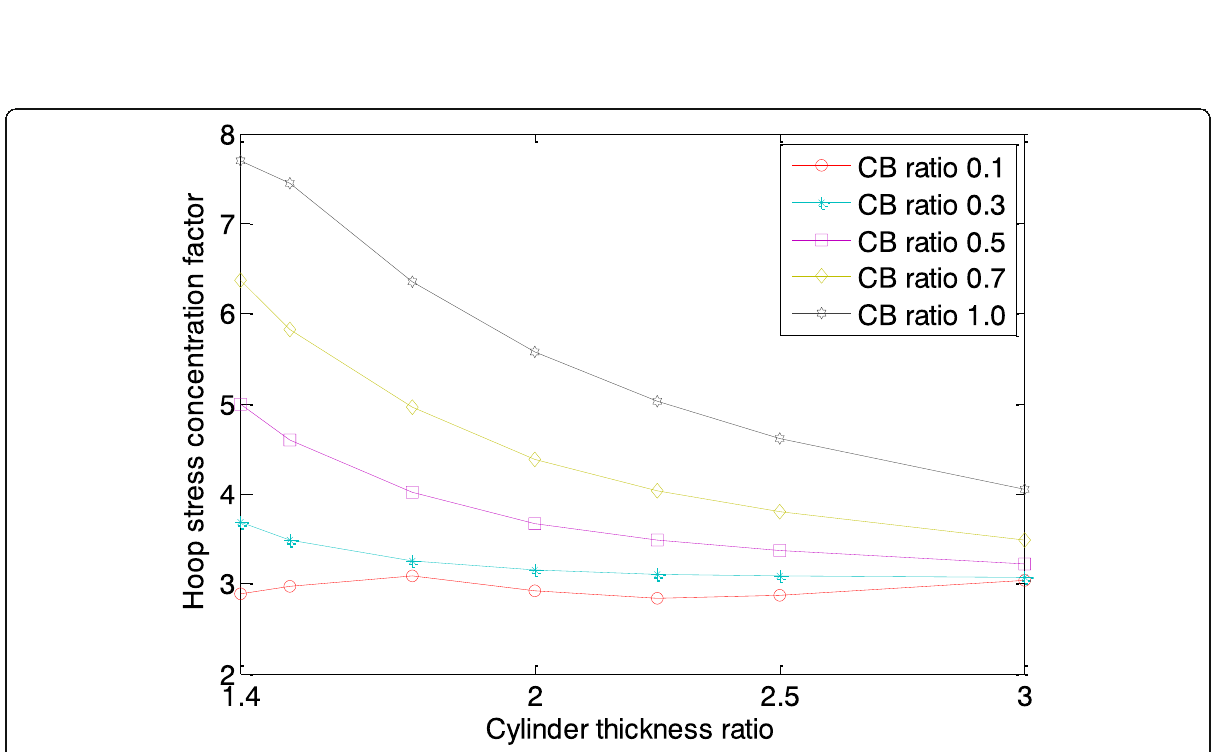
Fig. 7 Hoop SCF vs thickness